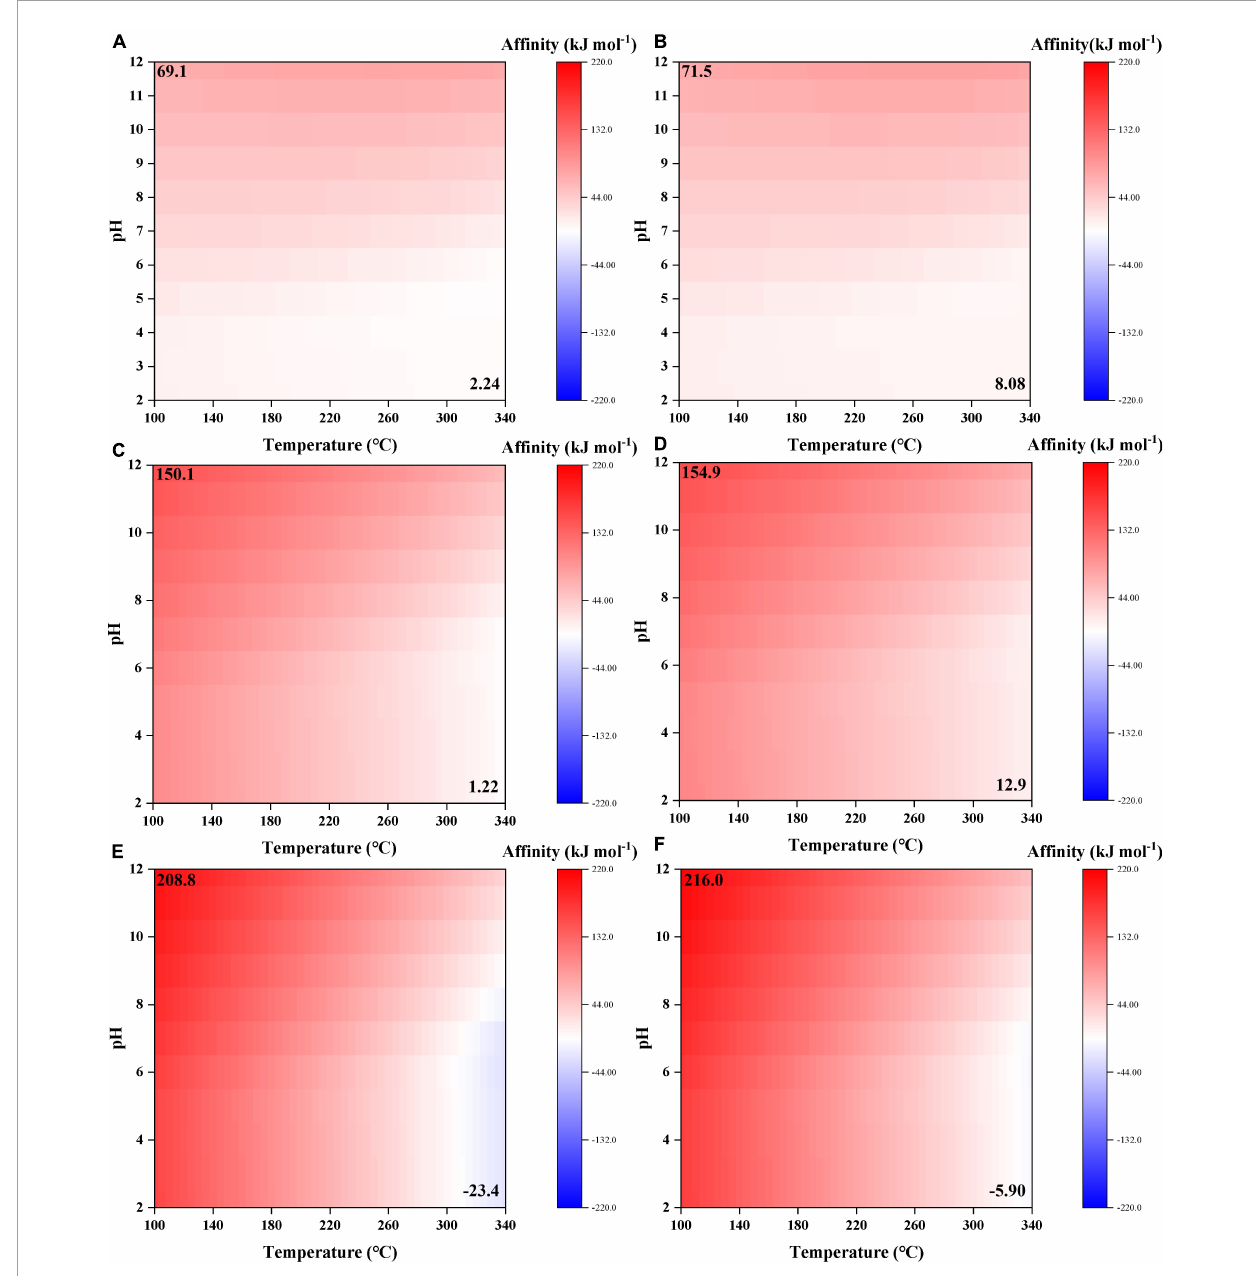
FIGURE3 Synthesis affinity of formic [HCOOH, aq + HCOO - ; (A,B) ], acetic [CH 3 COOH, aq + CH 3 COO - ; (C,D) ], and propanoic [C 2 H 5 COOH, aq + C 2 H 5 COO - ; (E,F) ] acids using (A,C,E) CO, g and (B,D,F) CO 2 , g as the carbon source.